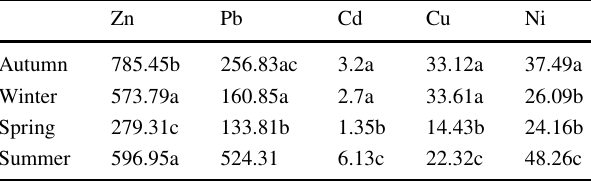
Table 5 Average element concentrations (mg kg) at four